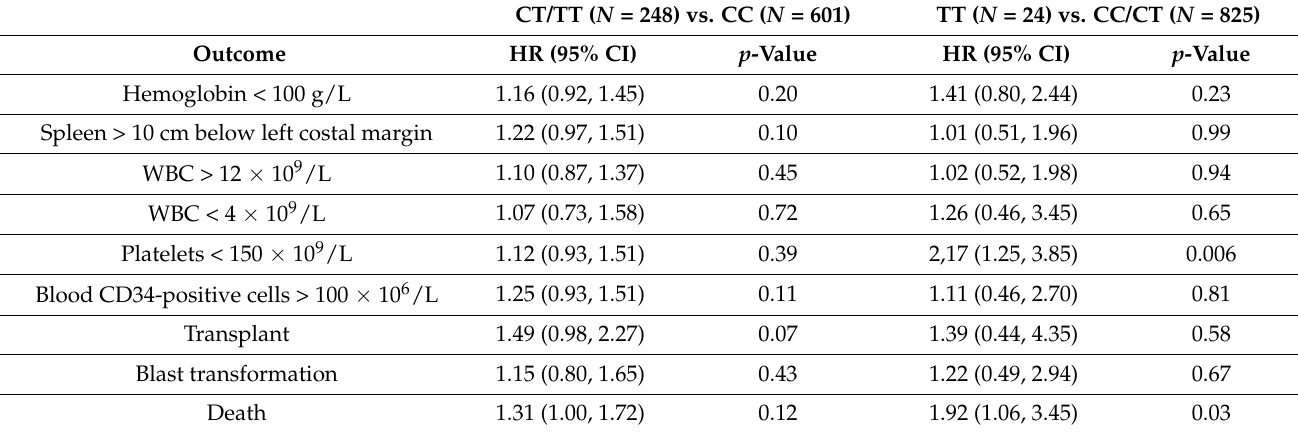
Table 3. Hazard ratio of the outcomes of subjects with PMF stratified according to the VEGFA 3025039 genotype. CT/TT ( N = 248) vs. CC ( N = 601) TT ( N = 24) vs. CC/CT ( N =